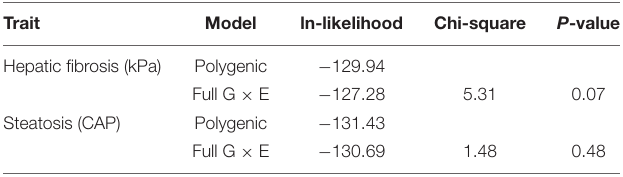
TABLE 3 | Testing the full G × E interaction model against the polygenic model.